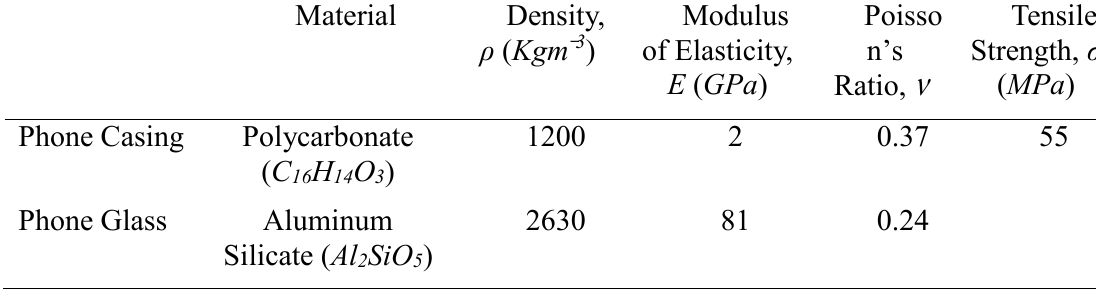
Material Properties of the Phone Casing and